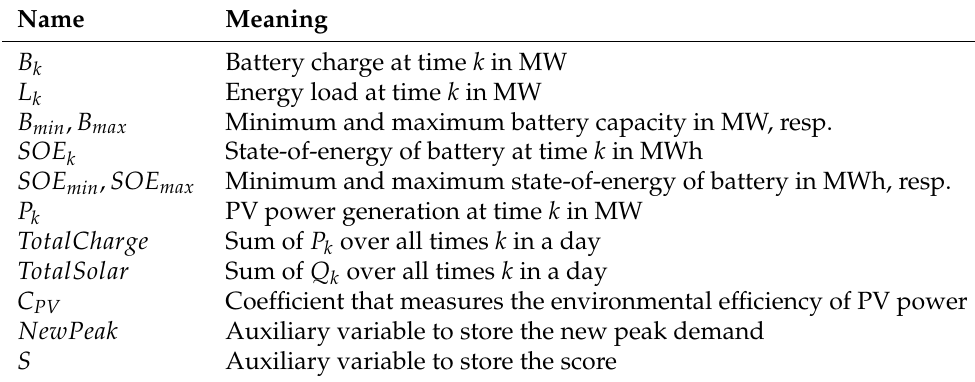
Table 1. Description of the variables and parameters used in the optimisation problem.